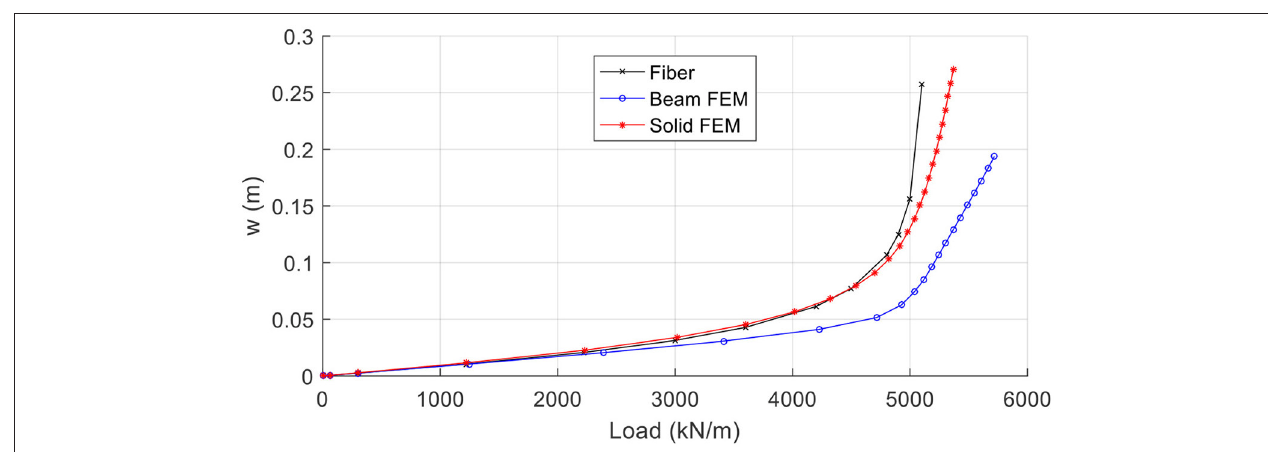
FIGURE 9 | Deflection at the middle of the beam vs. load in Example 2.